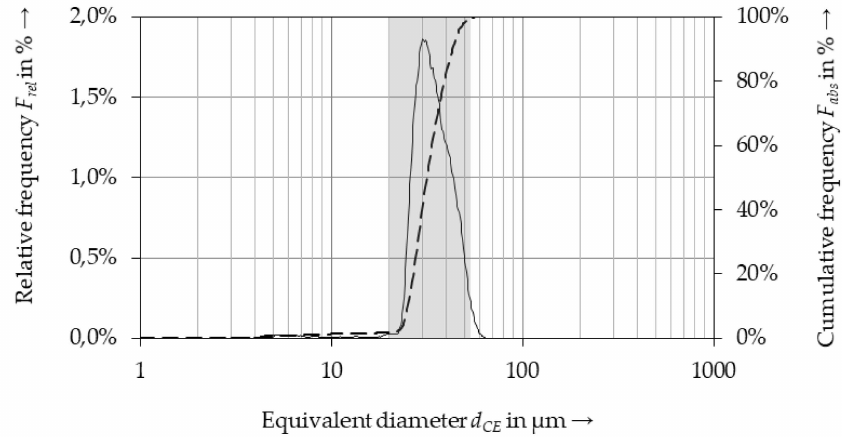
Figure 5. Relative F rel and cumulative number-weighted frequency distributions F abs against the equivalent diameter d CE . Gray box: Manufacturer’s specification with grain fraction − 53 + 20 µ m, mean grain diameter: 35.28 µ m [1]. Reprinted with permission from Ref [1]. Copyright 2020, Fraunhofer